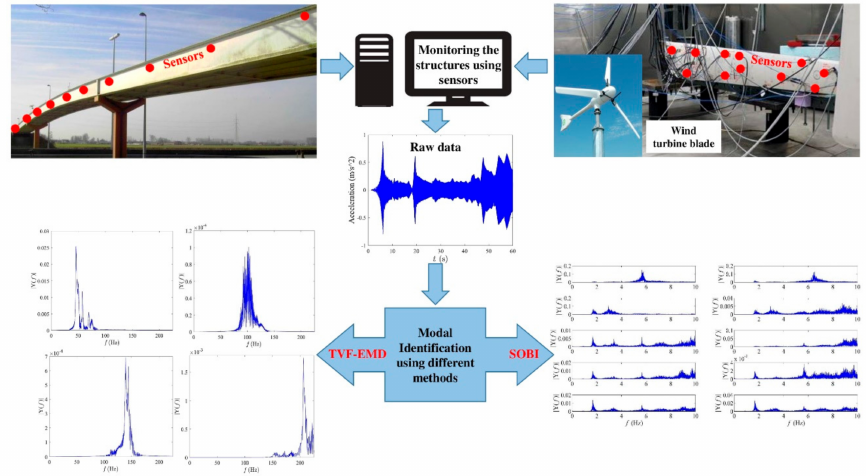
Figure 1. The outline of the proposed evaluation of two case studies.